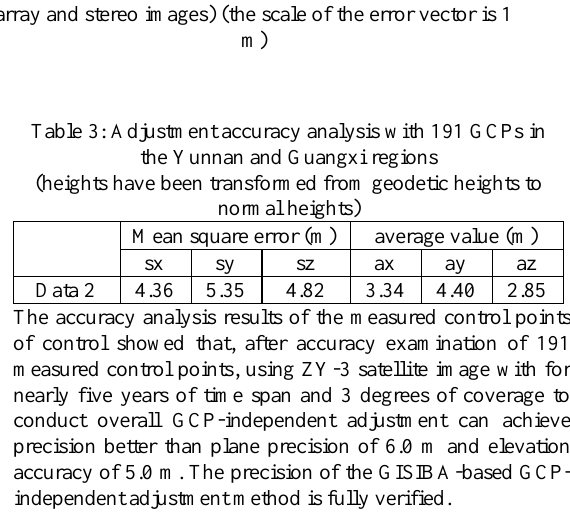
Fig 2: Test data 1: horizontal error distribution from 1300 check points for 23 ZY-3 satellite images (8 three-line array and stereo images) (the scale of the error vector is 10 m)